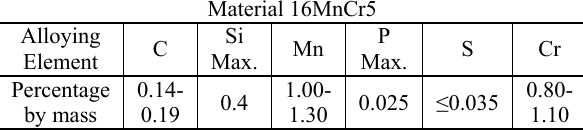
Table 2. Chemical composition of 16MnCr5 steel [24].